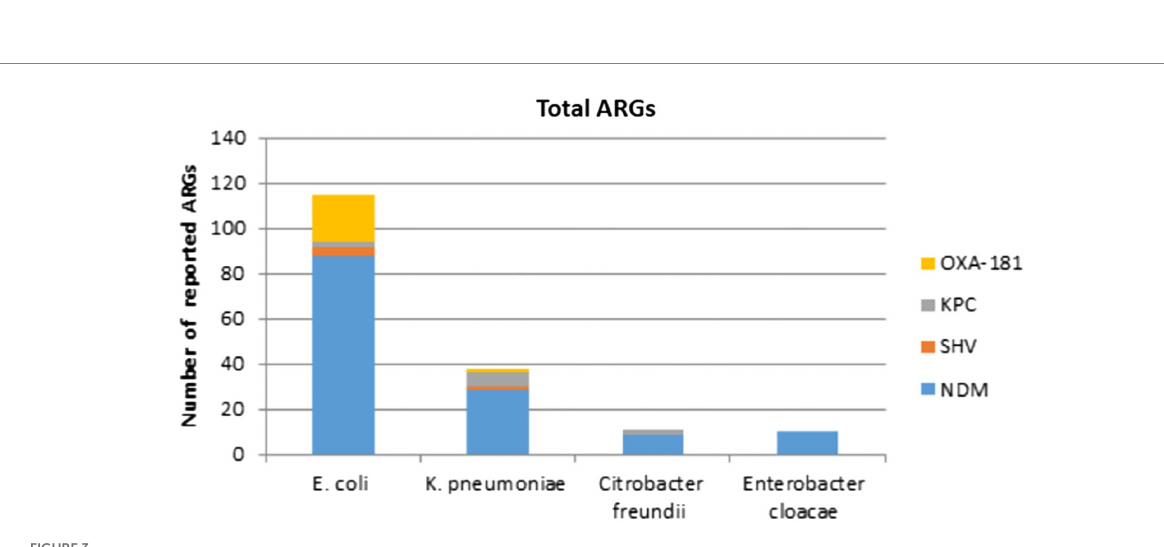
FIGURE 3 Number of carbapenemase genes reported in different species represented by this